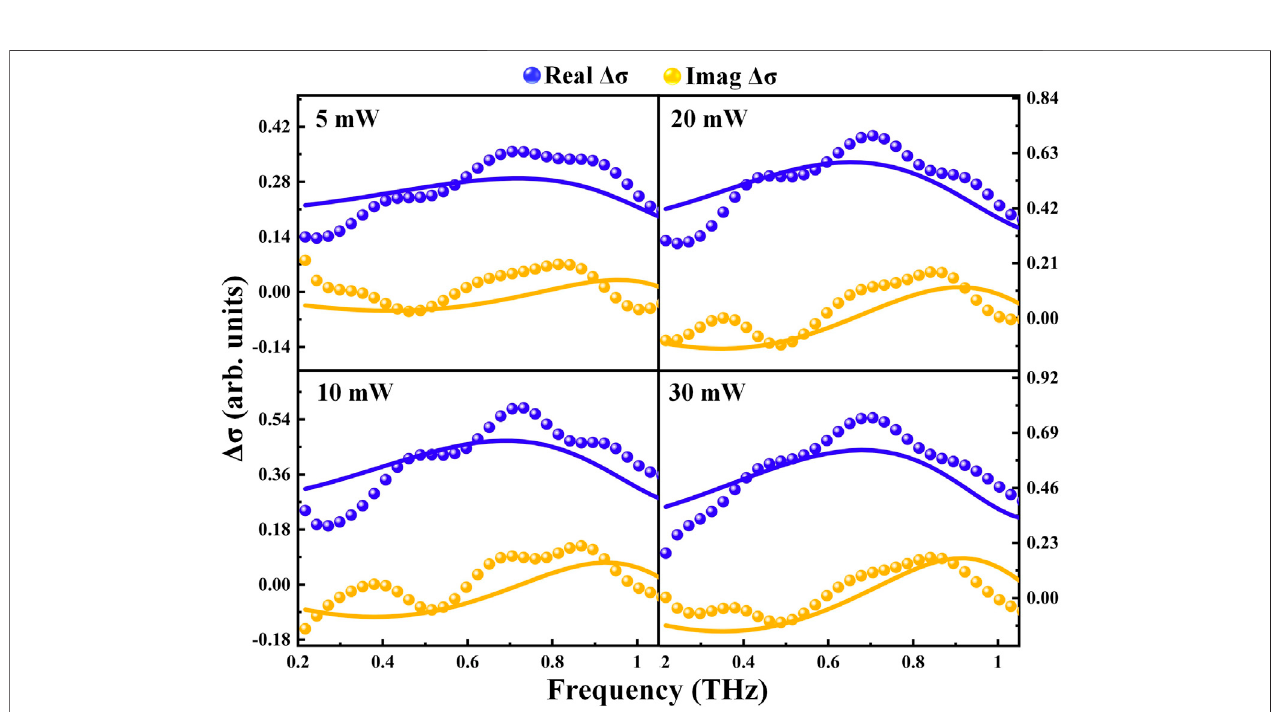
FIGURE5| Frequency-dependenttransientrealandimaginarypartsofthephotoconductivitymeasuredatthedelaytimeof5 pswithvariouspumppowerof5,10, 20, and 30 mW. The blue and yellow solid lines represent the fi tting results of the real and imaginary parts of photoconductivity by Drude – Smith-Lorentz model,